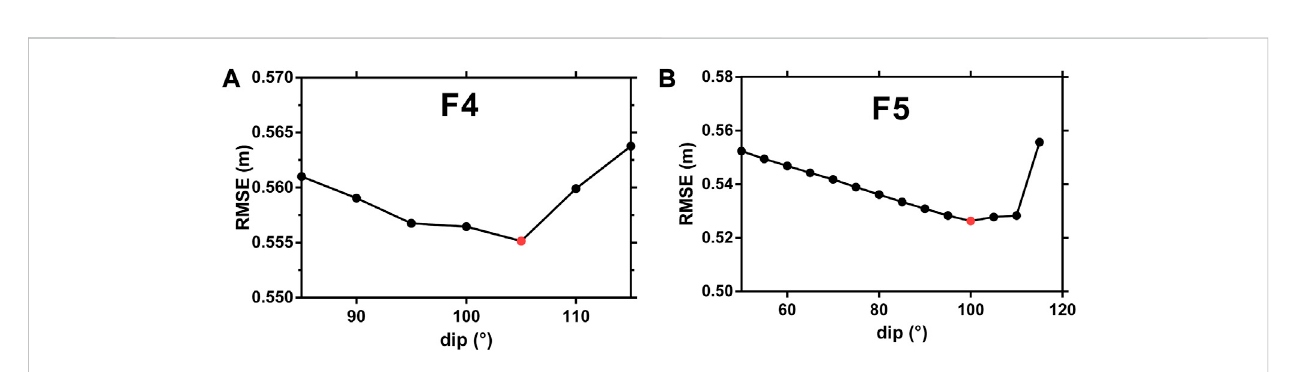
FIGURE 10 determination of optimal dip angle for segments F4 and